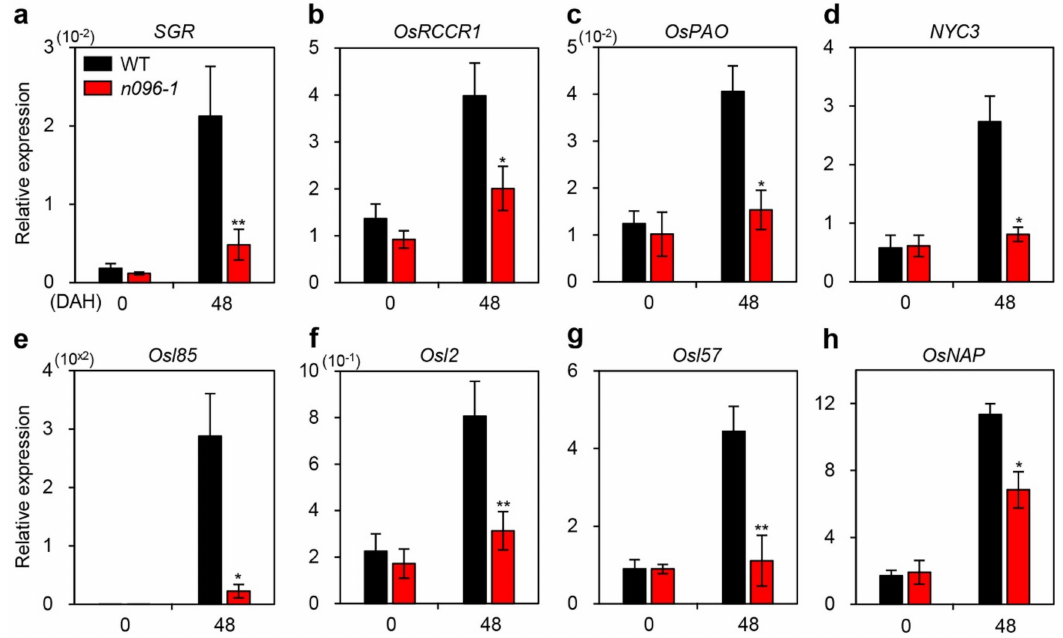
Figure 6. Altered expression of chlorophyll degradation genes (CDGs) and senescence-associated genes (SAGs) in onac096-1 during natural senescence. Total RNA was isolated from flag leaves of the WT and onac096-1 ( n096-1 ) at 0 and 48 DAH. The transcript levels of CDGs ( a – d ) and SAGs ( e – h ) were determined by RT-qPCR and normalized to that of OsUBQ5 . Relative expression was calculated using the ∆∆ C T method. Mean and SD values were obtained from three biological repeats. Asterisks indicate statistically significant di ff erences between onac096-1 and the WT at 48 DAH according to Student’s t -test (* p < 0.05 and ** p < 0.01). The experiments were repeated twice with similar